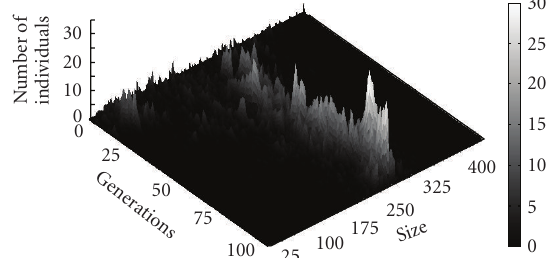
Figure 14: LiveDescribe experiment: chromosome size in the